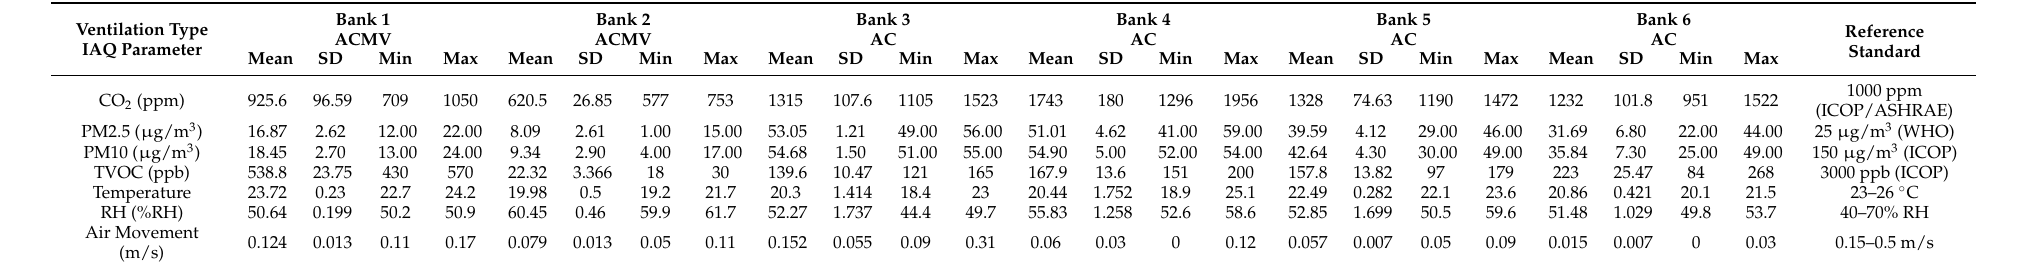
Table 4. Concentration of IAQ parameters at operation